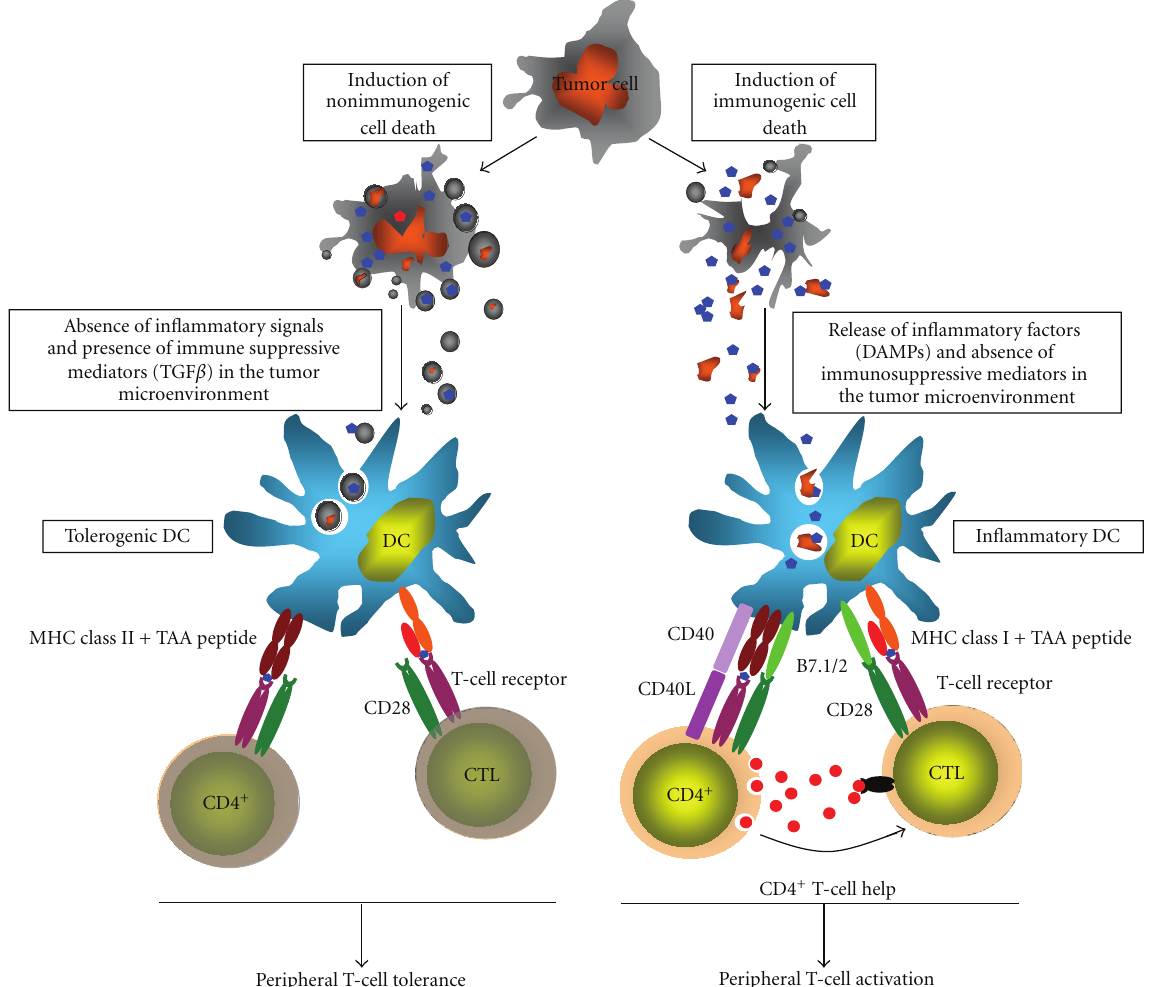
Figure 1: T-cell conversion from anergic to an activated status upon immunogenic cell death of tumor cells. The activation of tumor- specific T cells is dependent on DCs, which endocytose tumor cell debris and apoptotic vesicles. After intracellular processing the DCs present peptides derived from tumor-associated-antigens in complex with MHC class I molecules to T cells. Without the stimulation by danger-associated molecular patterns (DAMPs), DCs remain immature in a hostile immunosuppressive milieu and anergize CD4 + T cells and cytotoxic T cells (CTLs) resulting in peripheral tolerance. The release of inflammatory factors and the appearance of DAMPs lead to activation of DCs (inflammatory DCs) which subsequently upregulate costimulatory molecules of the B7 family. Inflammatory DCs are able to activate na¨ıve CTLs through MHC I tumor peptide/TCR and B7/CD28 crosslinking. Furthermore, inflammatory DCs can activate na¨ıve CD4 + T cells after MHC class II tumor peptide/TCR and B7/CD28 crosslinking. Activated CD4 + T cells in turn support clonal expansion and activity of CTLs by CD40/CD40L interaction and release of inflammatory cytokines such as